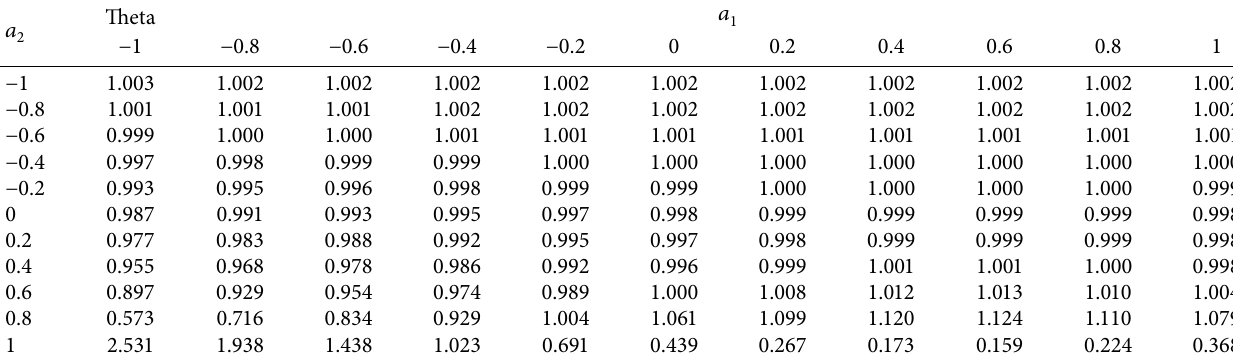
Table 2: Te critical discount varies with relationship preference.